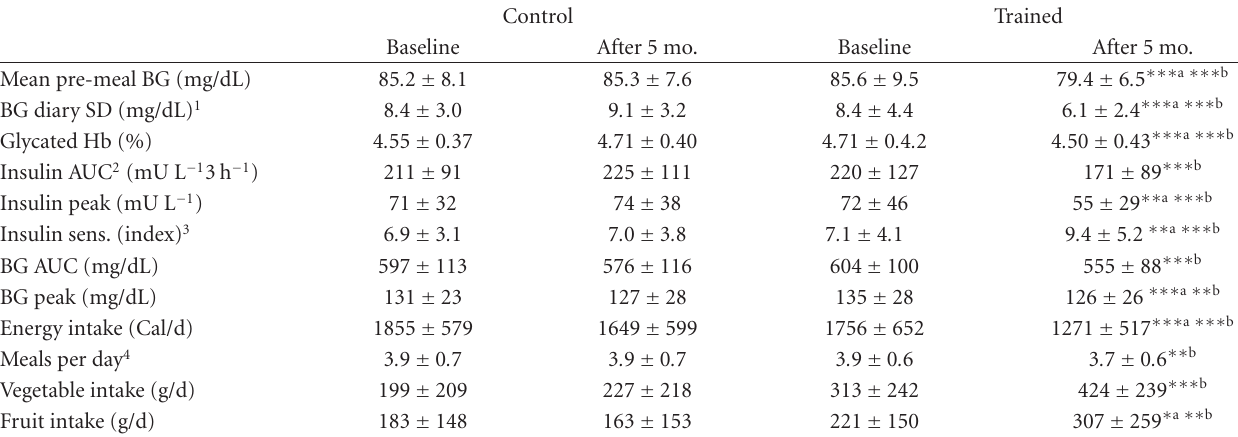
Table 2: E ff ects of training on metabolic and intake